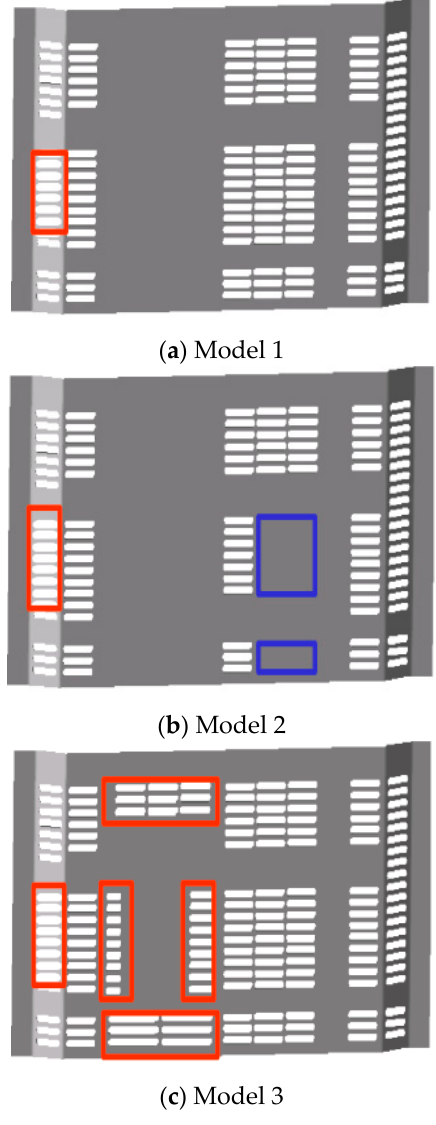
Figure 14. Modified structure of the CBM.